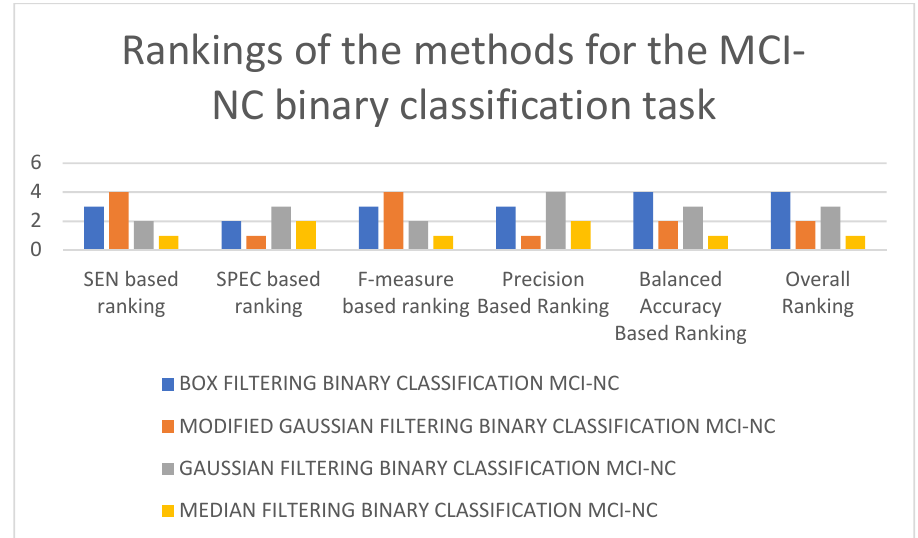
Figure 10. Rankings of different 3D-CNN architectures for the MCI-NC binary classification task.